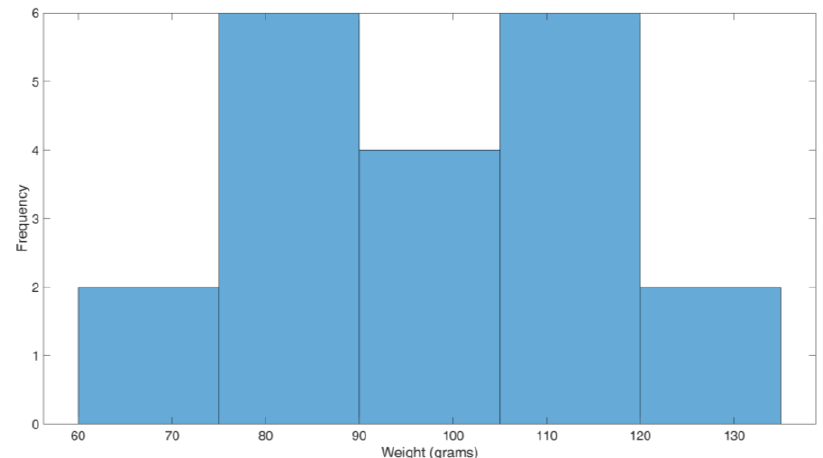
Figure 12. Kiwifruit weight distribution.